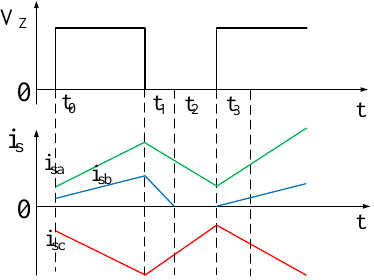
Figure 7. The phase current waveforms in a switching cycle during sector one.